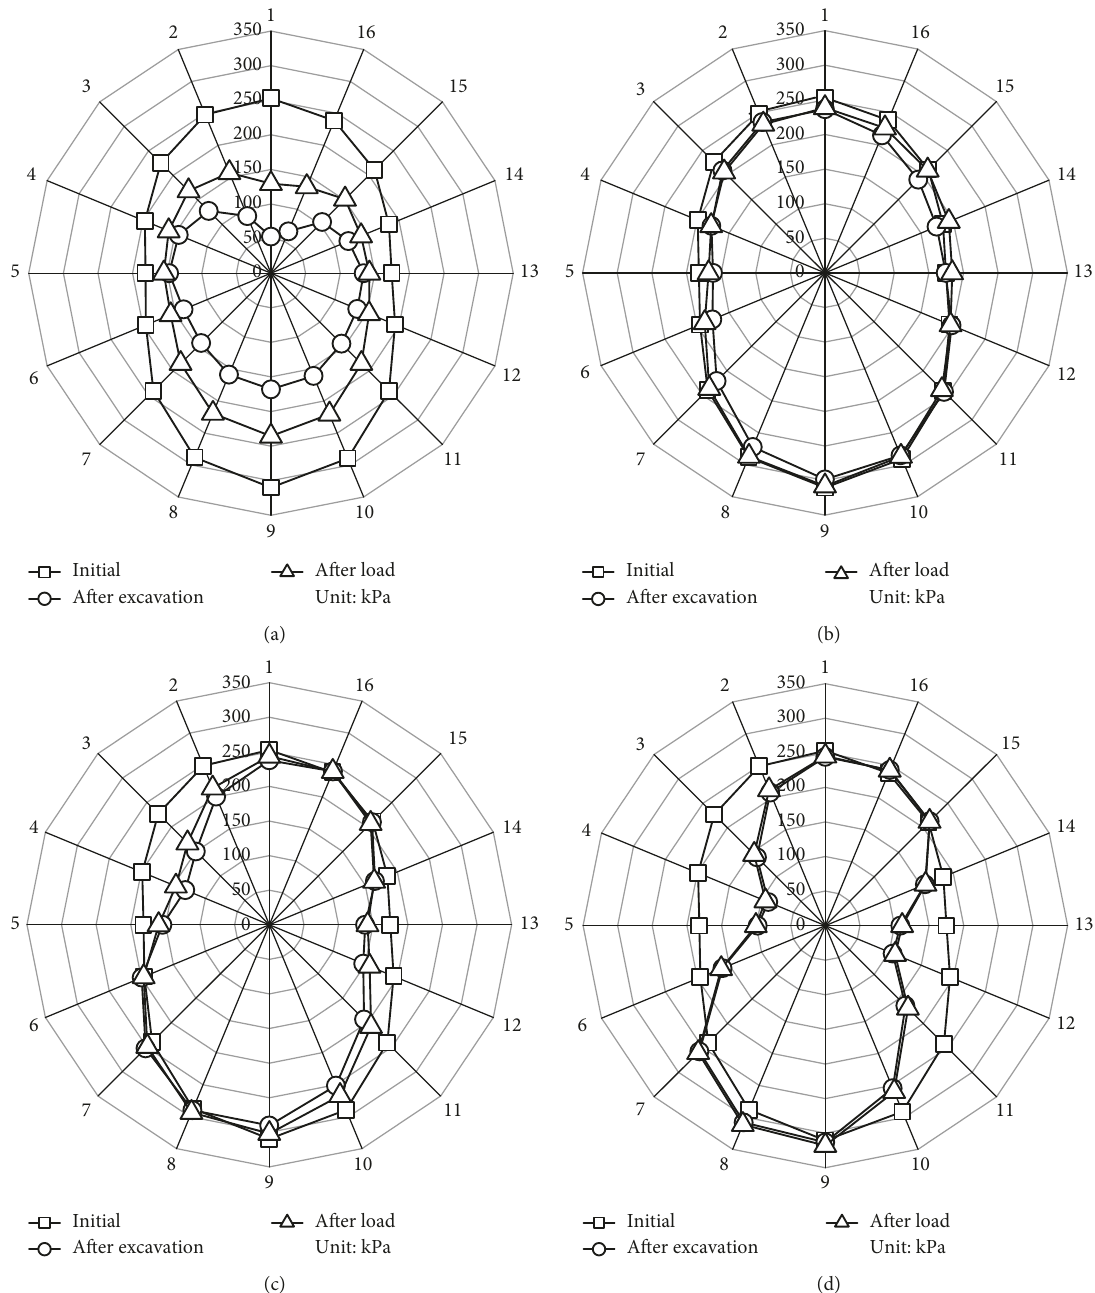
Figure 13: Radar diagram of the surrounding earth pressure on the tunnel. (a) Scheme 1. (b) Scheme 2. (c) Scheme 3. (d) Scheme